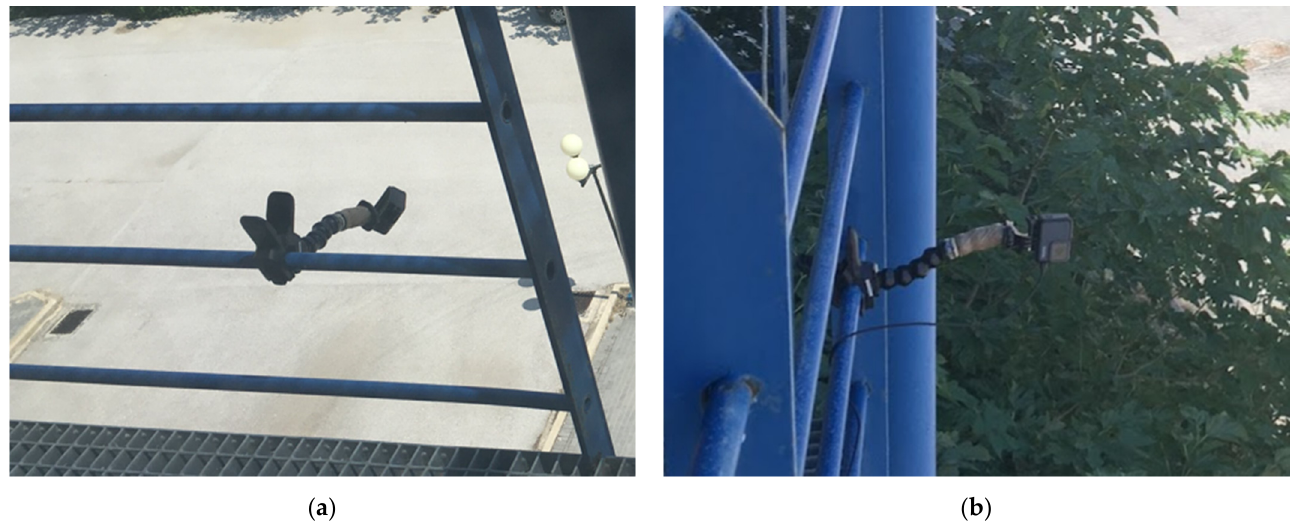
Figure 5. The RGB optical sensor ( a , b ), which was used during the data acquisition experiments to monitor the test throws of the human dummy, mounted on the perimeter of the building.